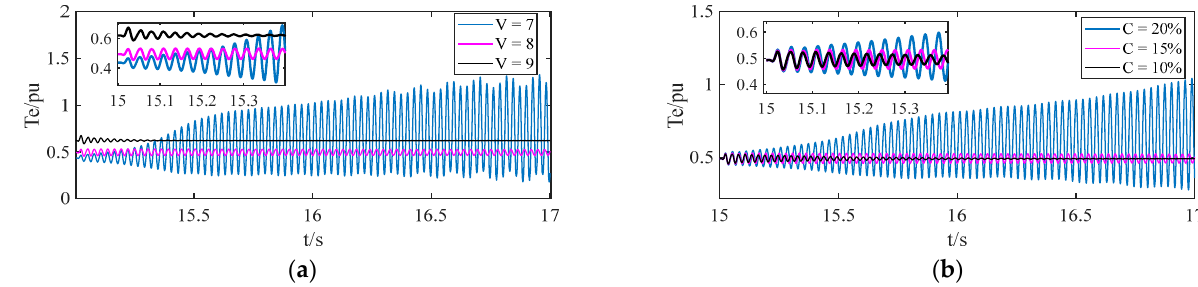
Figure 10. Electromagnetic torque at different wind speeds and compensation degrees: ( a ) different wind speed; ( b ) different compensation degree.